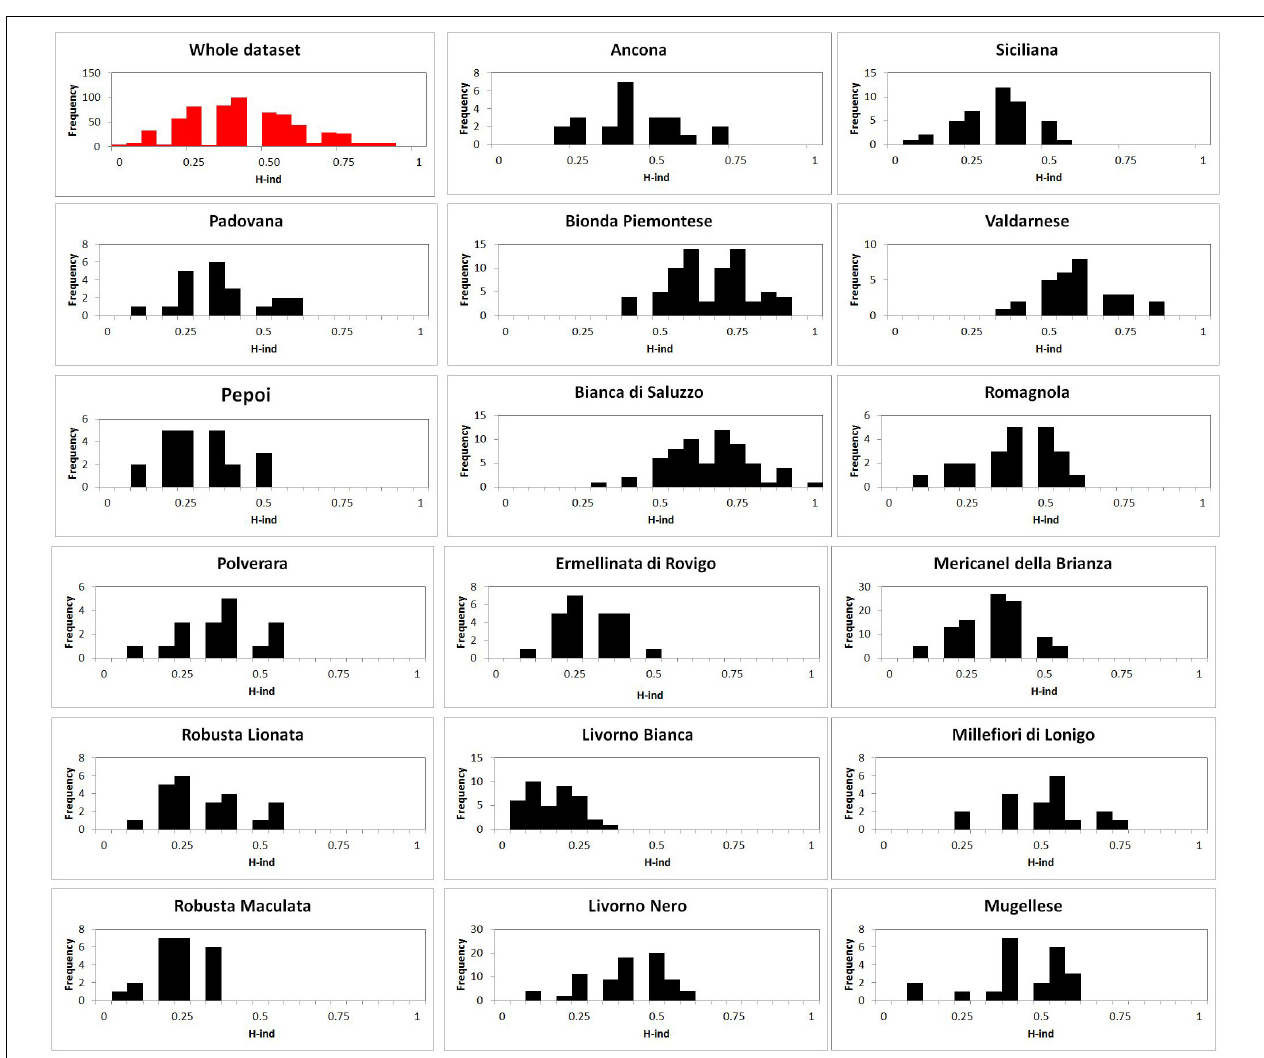
FIGURE 1 | Graphical output of individual heterozygosity value (Hind) distribution: in red whole dataset analysis, in black breed analysis.